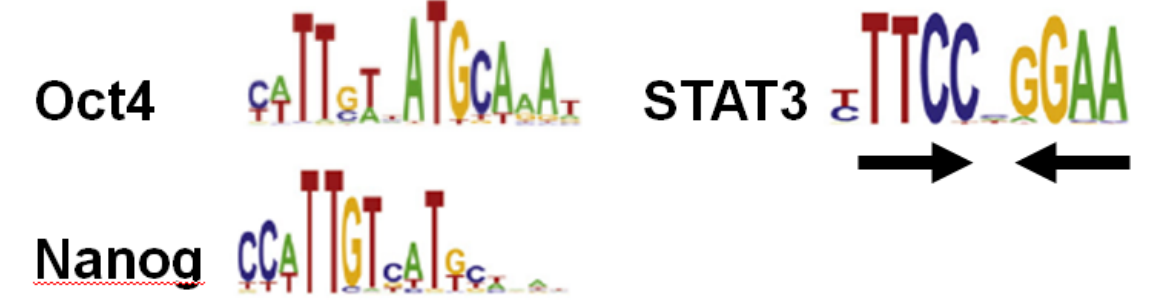
Figure 6: Binding motifs (logo) found in ChIP-seq peaks.